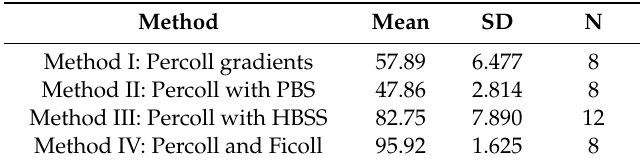
Table 1. Percentage mean purity of granulocyte isolation in each method.